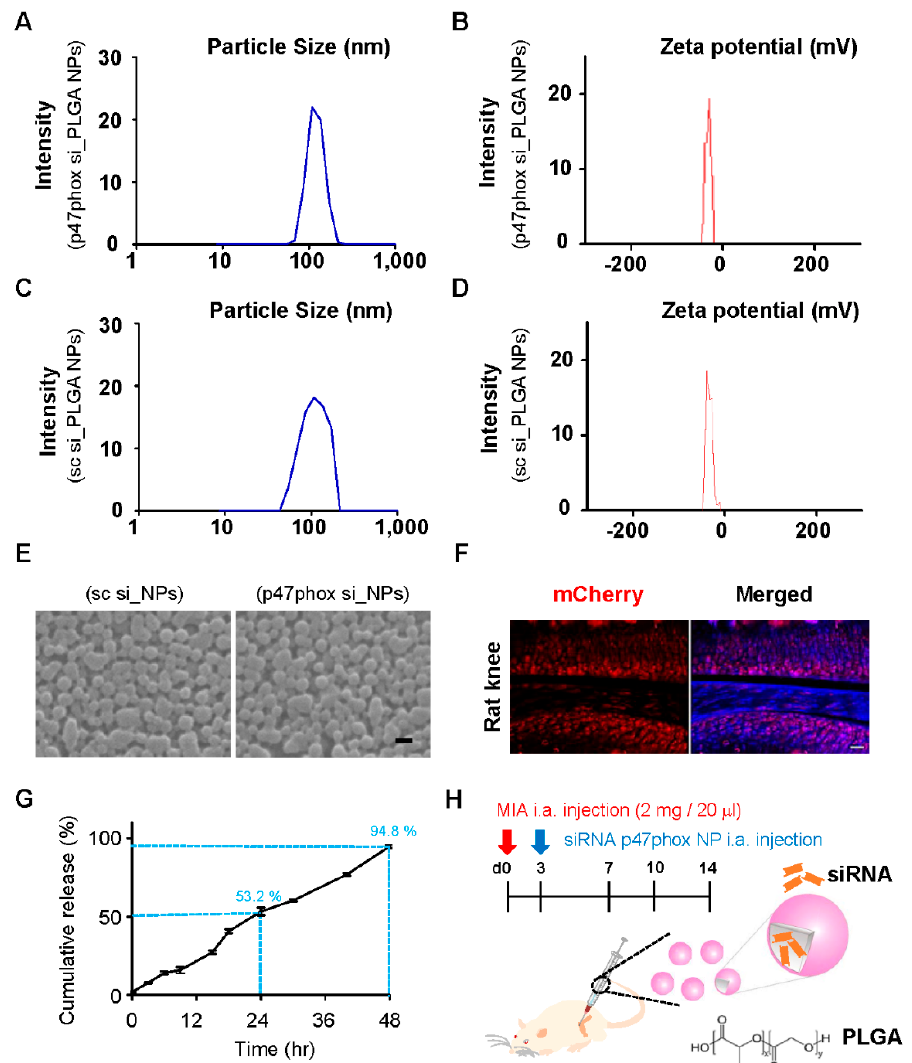
Figure 3. Characterization of p47phox siRNA-loaded poly (D,L-lactic-co-glycolic acid) (PLGA) nanoparticles (NPs). siRNA p47phox-encapsulated PLGA nanoparticles were dissolved in water and measured in terms of ( A , C ) size and ( B , D ) zeta potential by using a Zetasizer ZS90. ( E ) Suspended NPs were also assessed by using scanning electron microscopy; scale bar = 200 nm. ( F ) After 3 days, normal rat knees received intra-articular injections of AAV-mCherry expression vector-loaded PLGA NPs, 50 µm. ( G ) In vitro cumulative siRNA release of PLGA NPs over 48 h. ( H ) Experimental schematic of